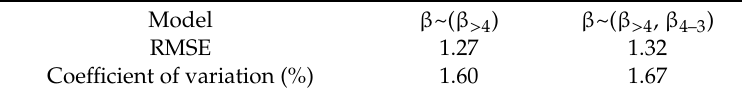
Table 1. Root-mean-square error (RMSE) and coefficient of variation (less = better) of linear regression models based on the same data.